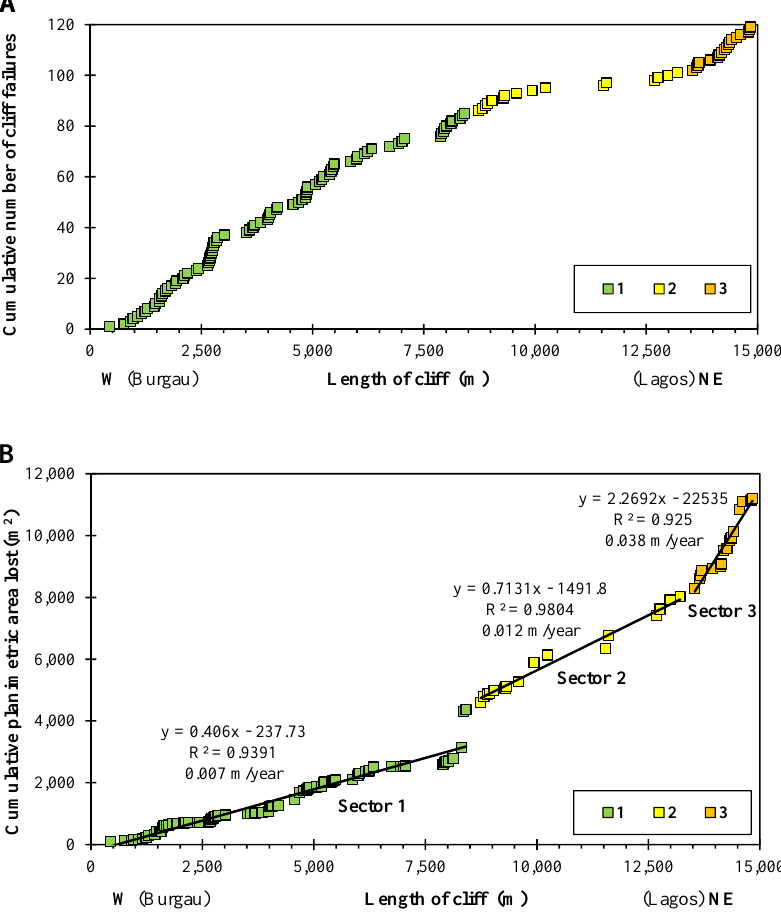
Fig. 2. Spatial distribution of cliff failures. (A) Cumulative number of cliff failures along the cliff lengths (from west to east). (B) Cumulative planimetric area lost at the level of the cliff tops, along the length of cliffs (sector extent in Fig. 1). The slope of the linear regressions corresponds to the mean retreat in metres for the 60 yr-long period of monitoring for each sector defined according to the frequency of cliff failures, planimetric area lost and geological units affected. Legend: 1 – Cliff failures in Cretaceous rocks; 2 – Cliff failures predominantly in Miocene calcarenites; 3 – Cliff failures predominantly in Plio-Pleistocene silty sands.